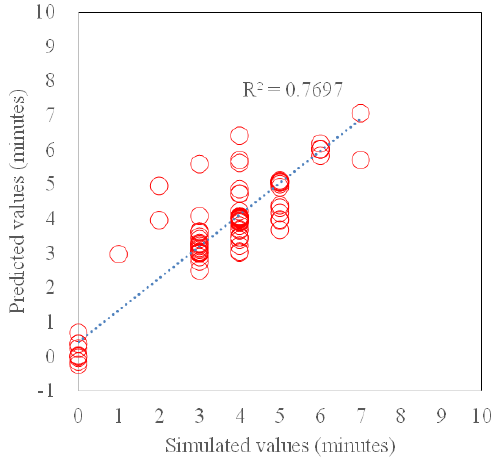
Figure 12. Statistical relationship (R 2 ) between the simulated values (Si) and the predicted values (Pi).